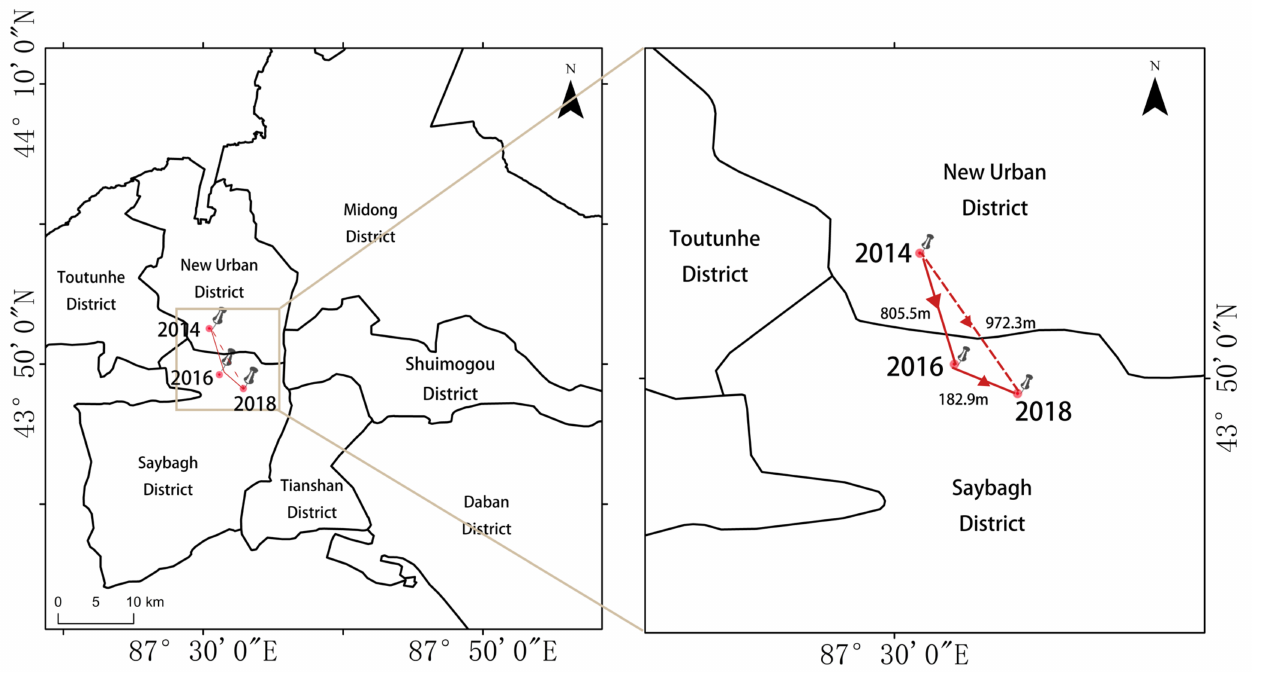
Figure 6. Changes in the center of gravity of HFMD from 2014 to 2018.